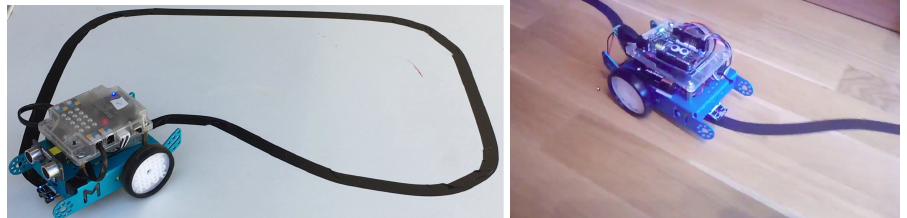
Figure 7. mBot robot following a line with a reconfigurable computing brain ( left ) vs. with a software brain ( right ).